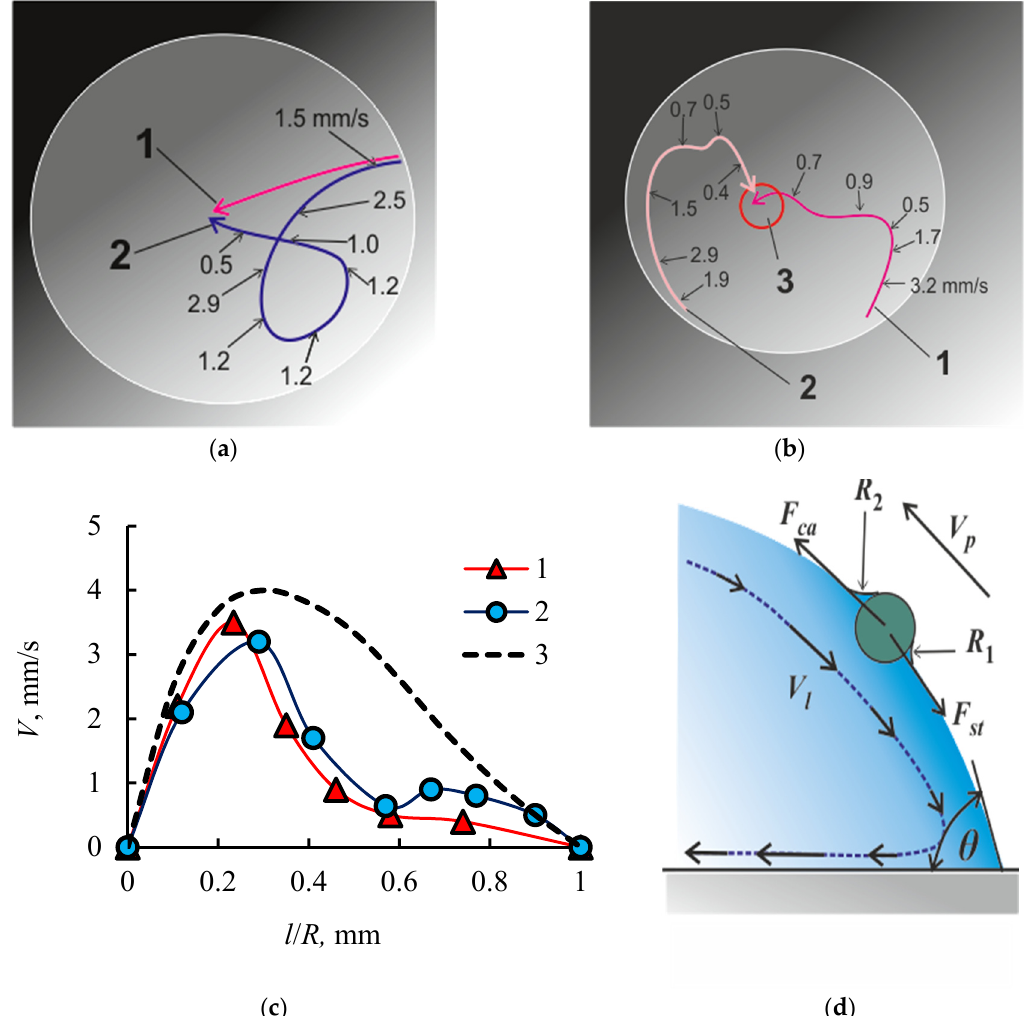
Figure 13. ( a , b ) Trajectory of the particle on the drop surface: 1, 2—particle trajectory; 3—the area of the toroid center; ( c ) particle velocity on the drop surface: 1, 2—experiment; 3—modeling by (4); ( d ) forces acting on the particle.